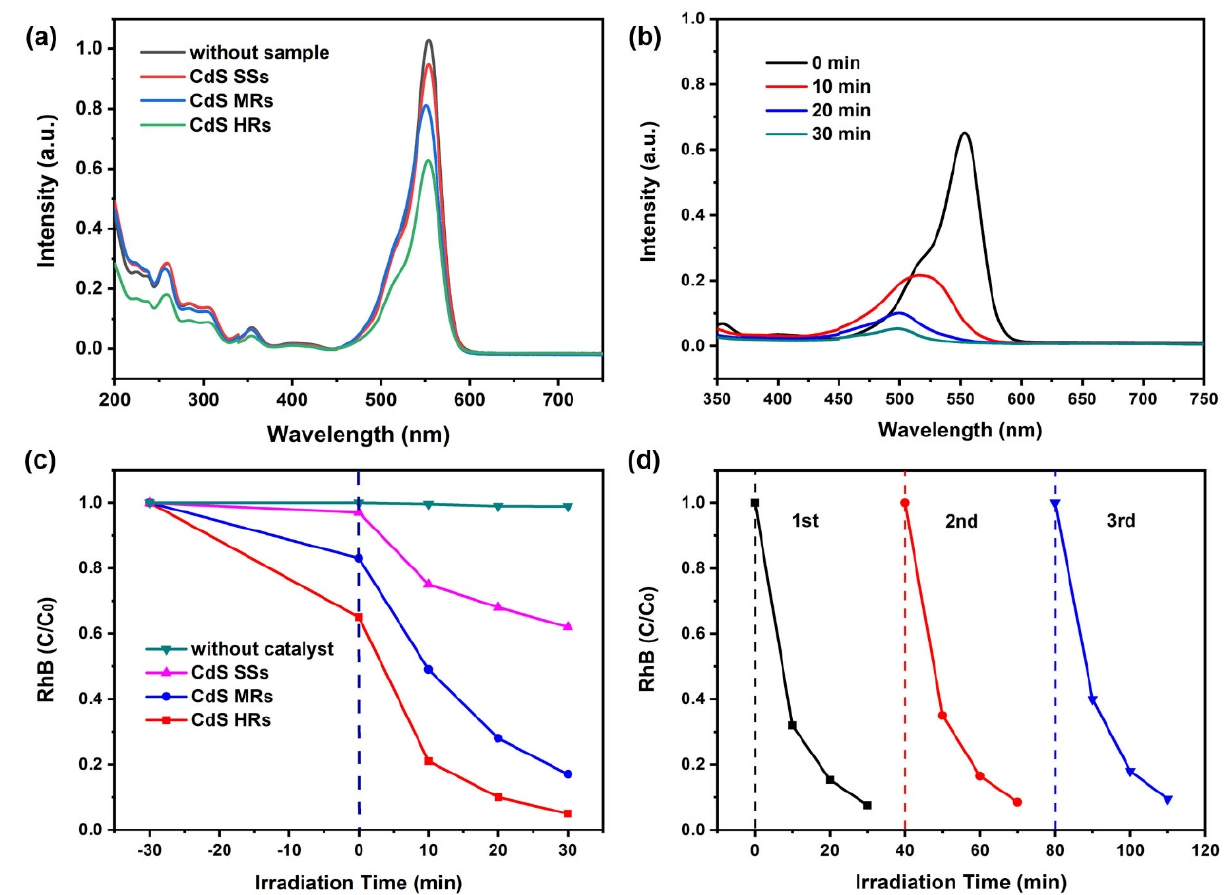
Figure 6. ( a ) Adsorption properties of samples; ( b ) the degradation curves of CdS HRs under visible light for 30 min; ( c ) the degradation rate of RhB by different samples; ( d ) the repeatability tests studied on the CdS HRs for three recycles.